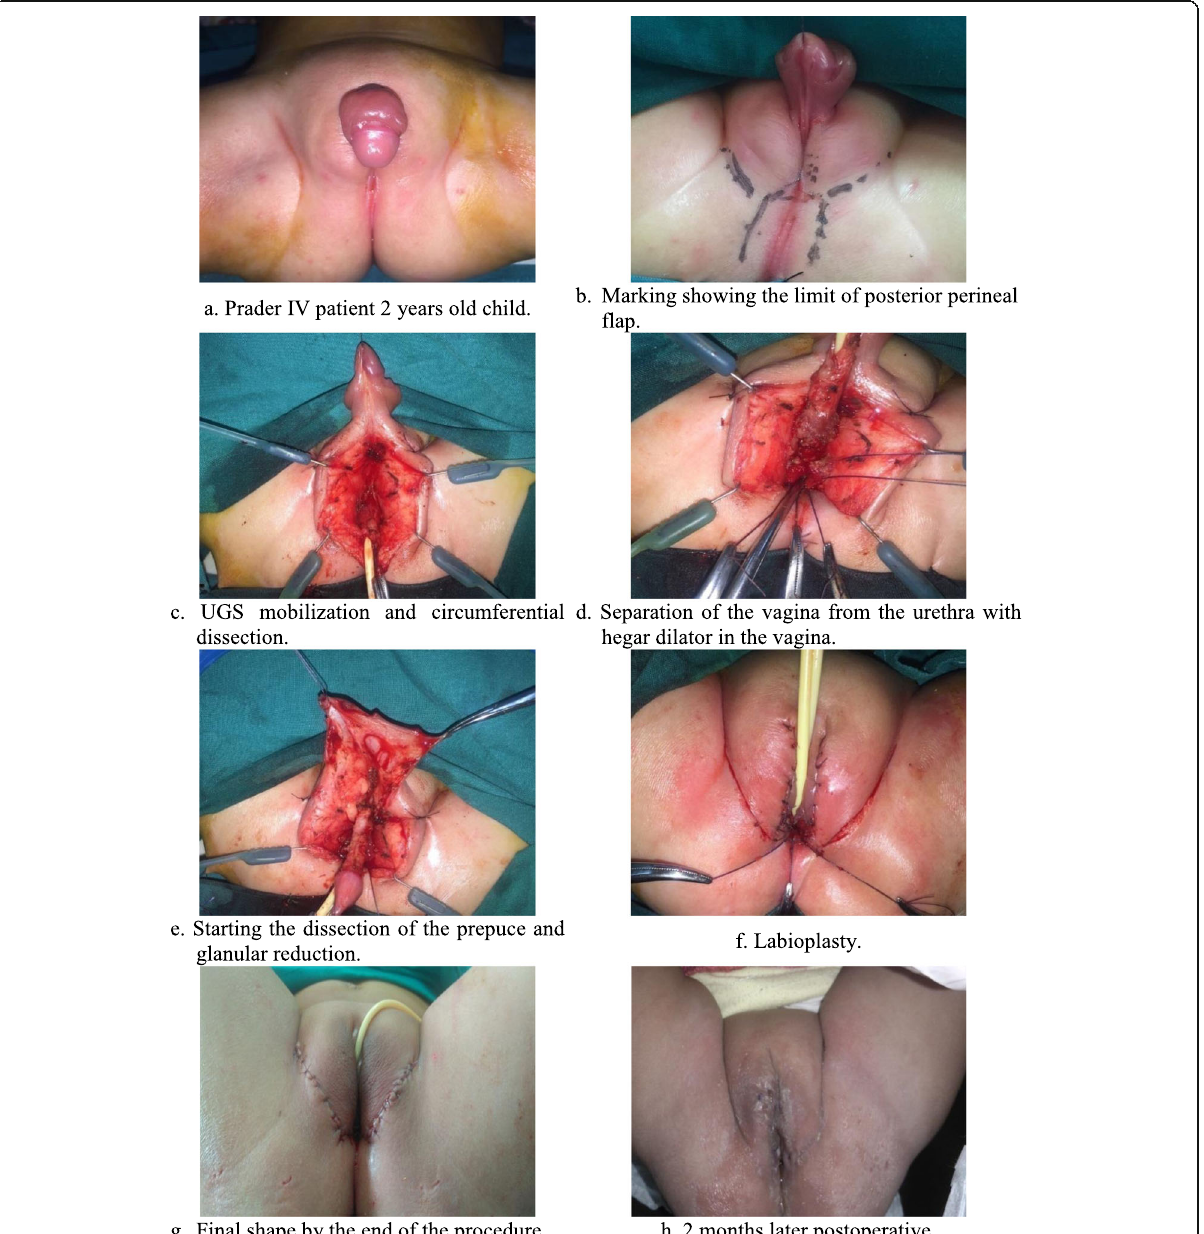
Fig. 1 a Prader IV patient 2 years old child. b Marking showing the limit of posterior perineal flap. c UGS mobilization and circumferential dissection. d Separation of the vagina from the urethra with hegar dilator in the vagina. e Starting the dissection of the prepuce and glanular reduction. f Labioplasty. g Final shape by the end of the procedure. h 2 months later